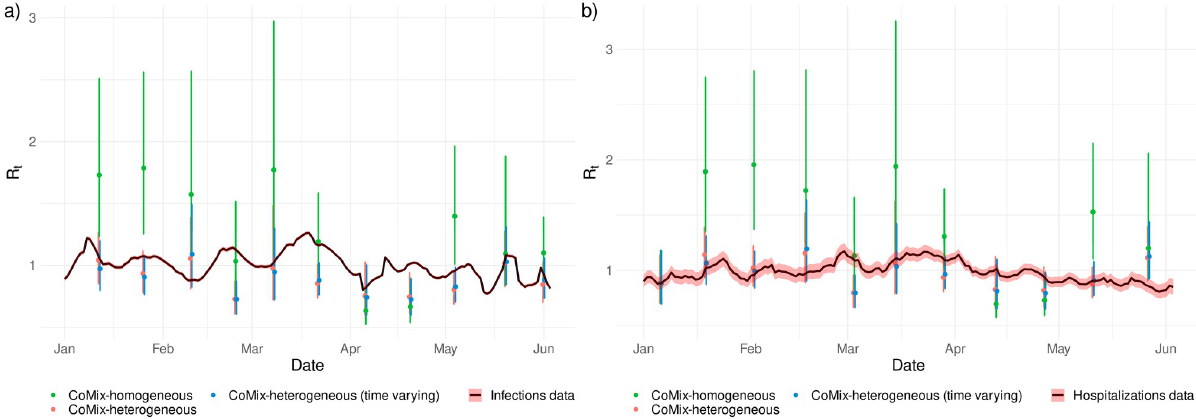
Fig 5. Temporal reproduction number. Reproduction number estimated from the CoMix data using the next generation approach in comparison to the reproduction number estimated from the number of confirmed cases (a) and from the number of hospitalizations (b). In green: estimated R under t the assumption of a homogeneous proportionality factor. In red: estimated R t with the estimated age-specific q -susceptibility under the assumption on age-specific infectiousness as in Figs 1 and 2. In blue: estimated R with the estimated temporal and age-specific q -susceptibility under the assumption t on age-specific infectiousness as in Fig 4. Dots represent means and bars represent 95% percentile (nonparametric) bootstrap-based confidence intervals.